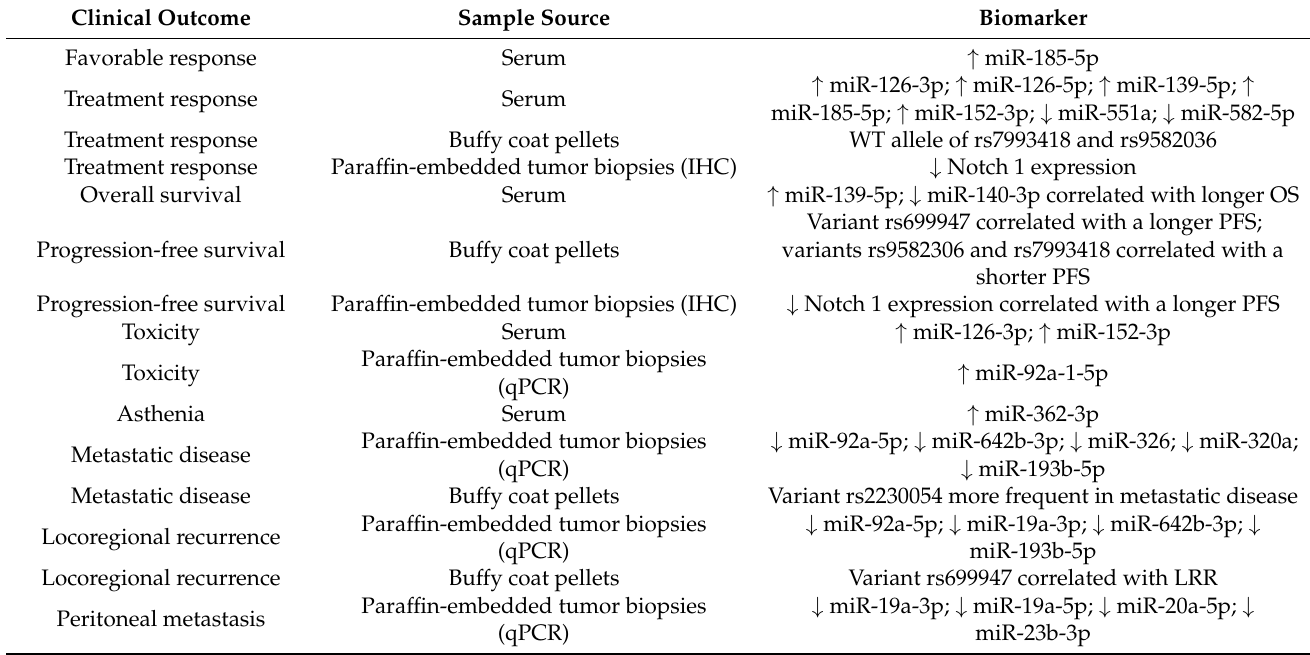
Table 5. Validated biomarkers. Relevant results are shown indicating the sample used, the technique of detection, and the clinical outcome.